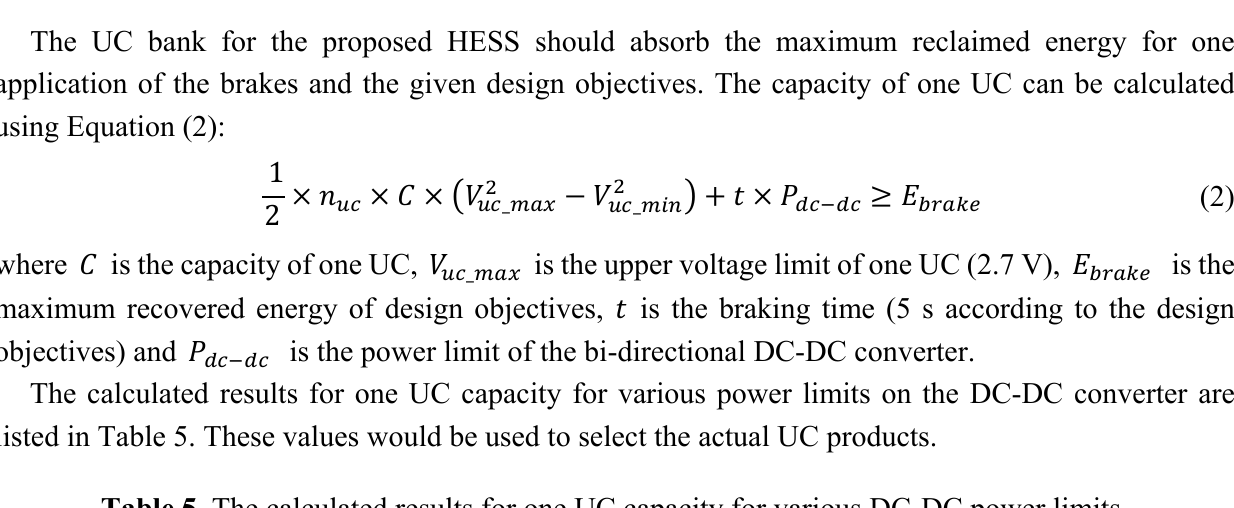
Table 5. The calculated results for one UC capacity for various DC-DC power limits. DC-DC power limit (kW)